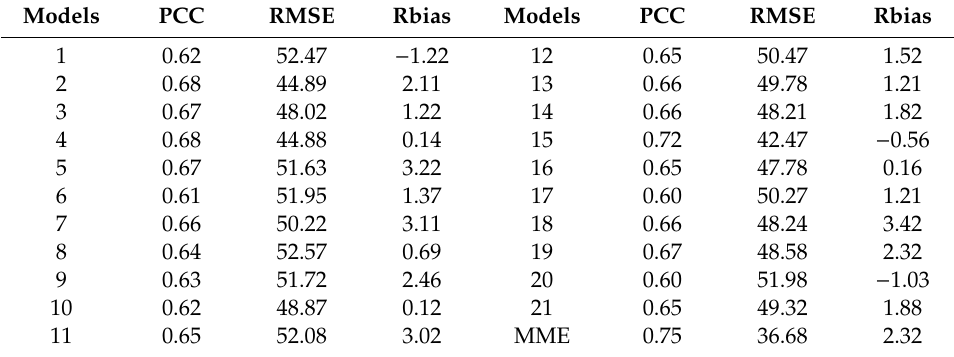
Table 5. Performances of 21 single National Aeronautics and Space Administration (NASA) Earth Exchange Global Daily Downscaled Projections (NEX-GDDP) models and simple model average (MME) for the region